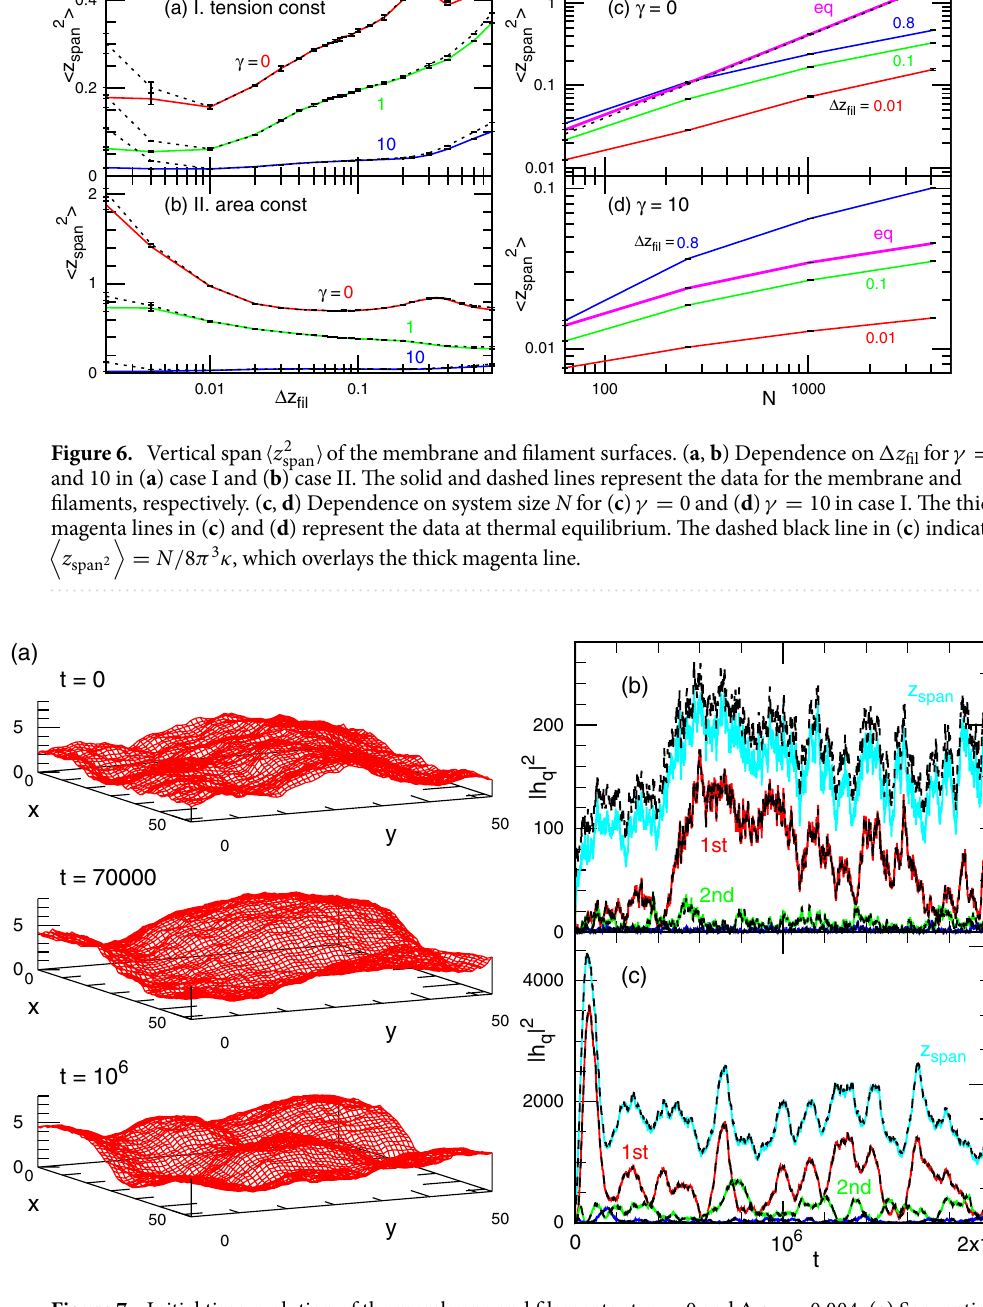
Figure 7. Initial time evolution of the membrane and filaments at γ snapshots corresponding to the data in ( c ). ( b , c ) Time evolution of the amplitudes of the first, second, and third modes along the x -axis and the vertical span z span in ( b ) case I and ( c ) case II. The solid and dashed lines represent the data of the membrane and filaments, respectively. The time unit is MC step. In both cases, a thermal equilibrium membrane conformation is used as an initial state; the initial filament surface is flat and contacts to the minimum position of the